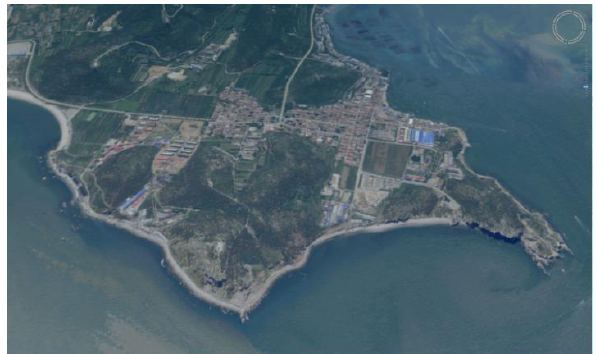
Figure 14. Sea erosion and marine accumulation landform